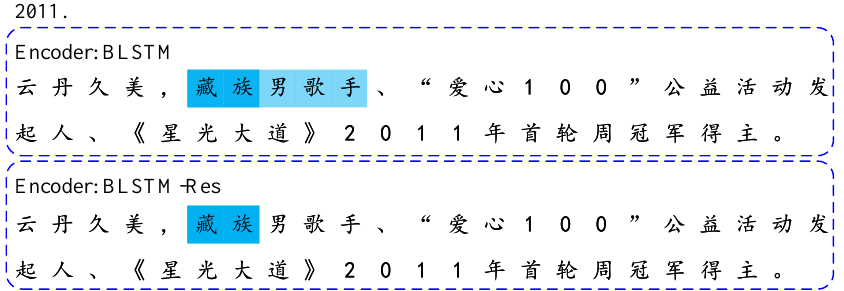
Figure 5. Attention analysis of ‘ 民 族 ’ relation, the darker the color is the higher the weight